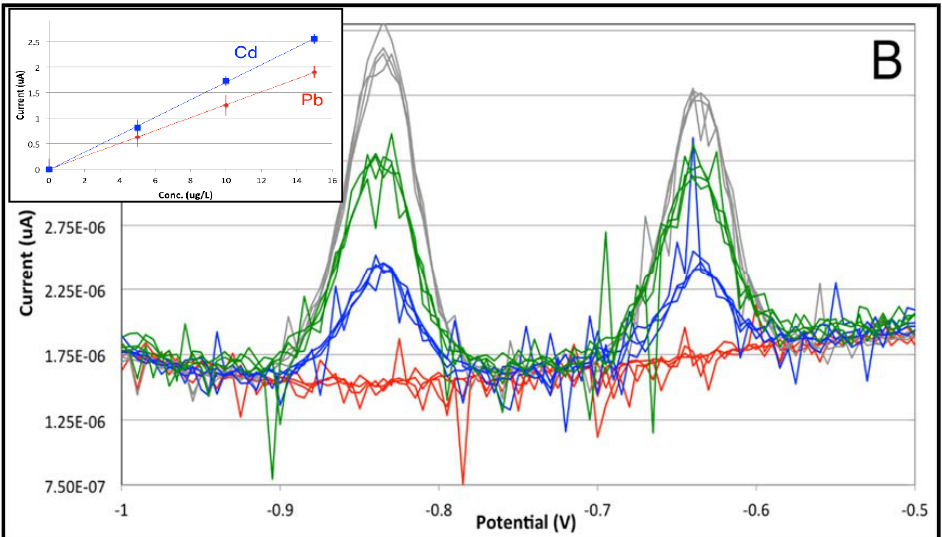
Figure 5. Comparison of stripping analysis signals of Pb and Cd between 0 and 15 μ g/L with a preconcentration time of 60 s. ( A ) Using batch cell; ( B ) using stopped ‐ flow conditions. Inset: Calibration lines for Cd (in blue) and Pb (in red). Reference electrode: internal pseudo ‐ reference.